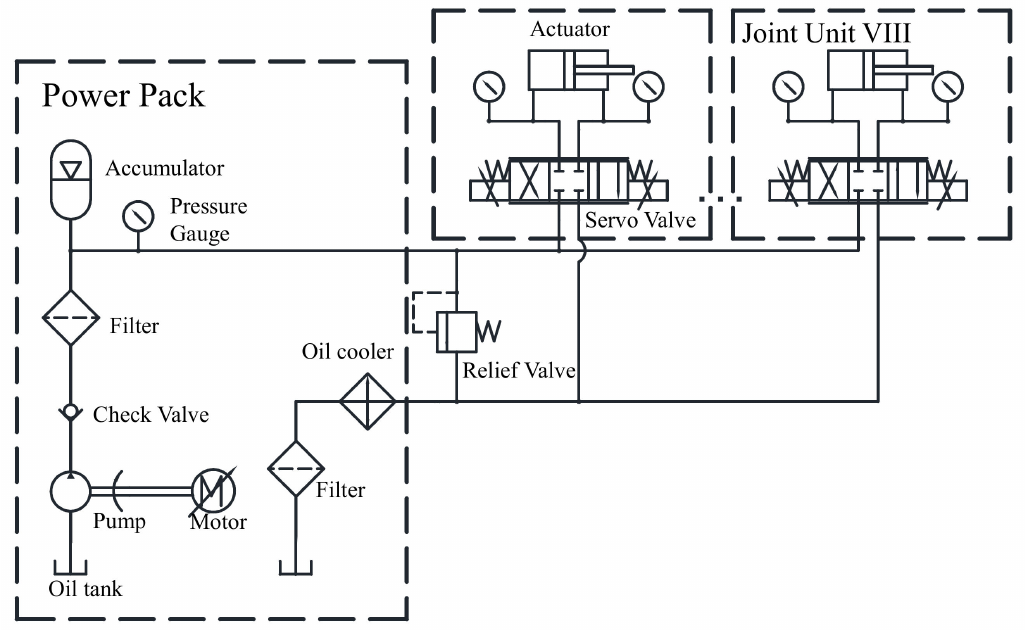
Figure 2. Schematic of WLBOT hydraulic